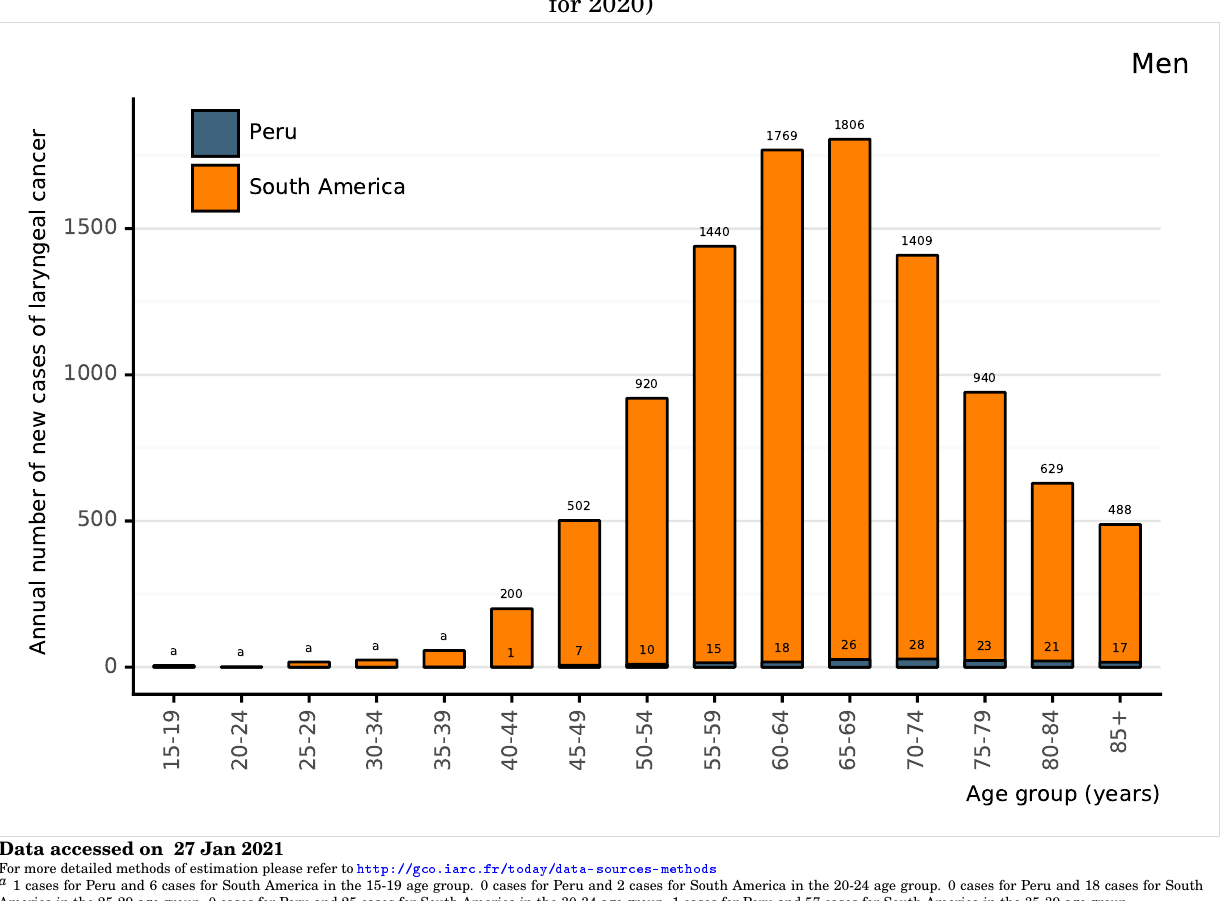
Figure 101: Annual number of new cases of laryngeal cancer among men by age group in Peru